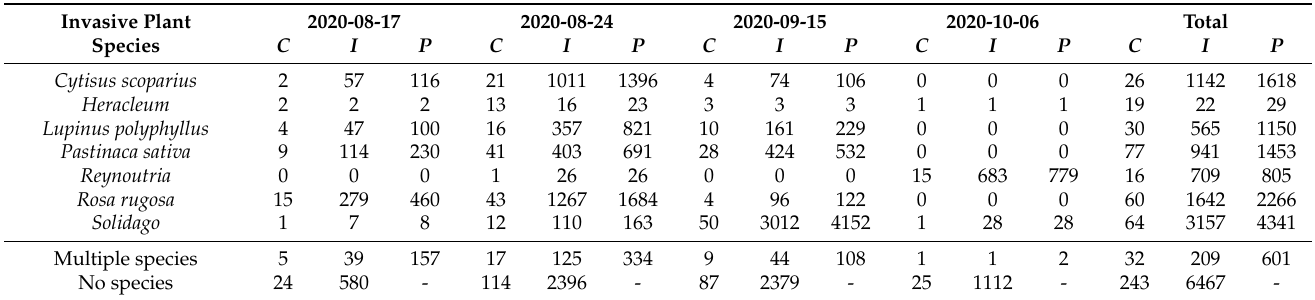
Table 1. Overview of collected and annotated images. C and I are the number of clusters and number of images each species appear in on a given date, respectively. P is the number of annotated polygons of a each species on a given date. A cluster consists of multiple images acquired from the same location—potentially across multiple dates. An image contains zero, one, or multiple